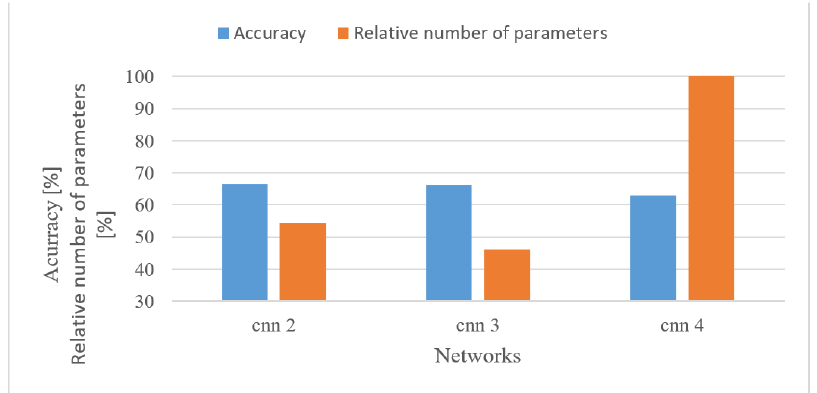
Figure 20. Averaged accuracies and relative numbers of trainable parameters for custom 2, 3, and 4 convolutional layer CNNs (CNN 2, CNN 3, CNN 4), and 0–8 kHz spectrograms.